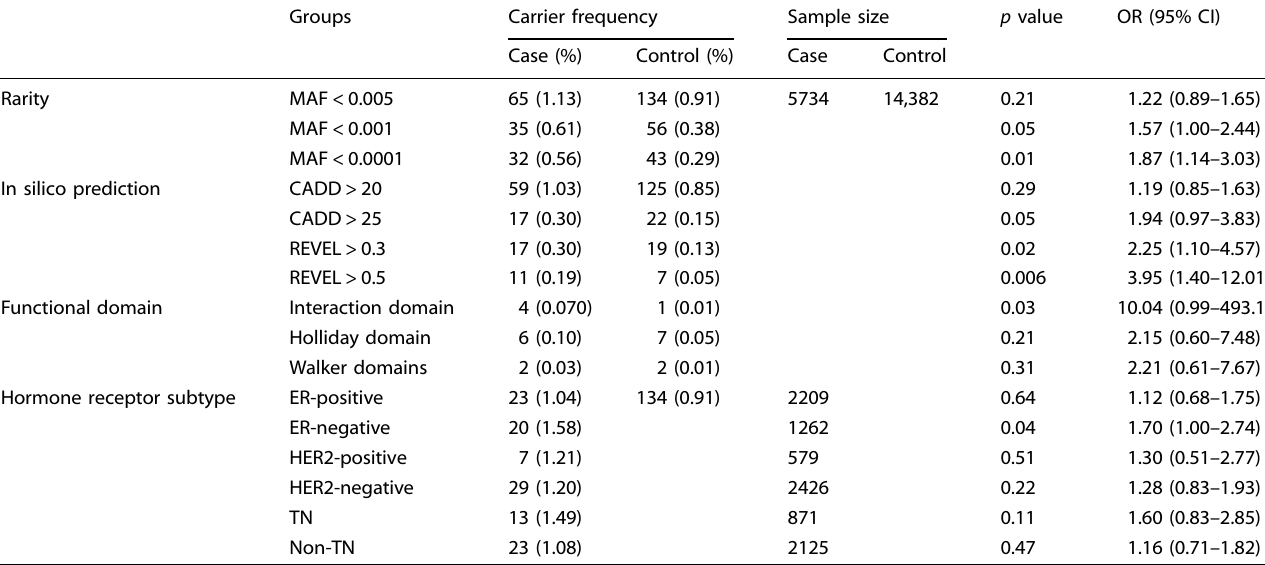
Table 1. Frequencies of RAD51C MS variants in case and control cohorts according to different fi ltering criteria to enrich for likely pathogenic